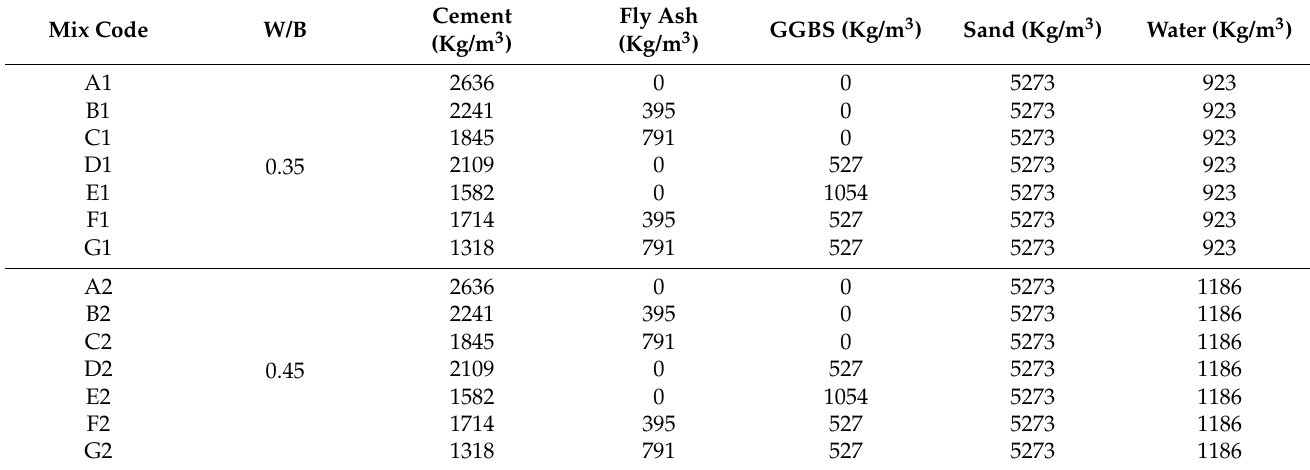
Table 3. Mix proportions of the